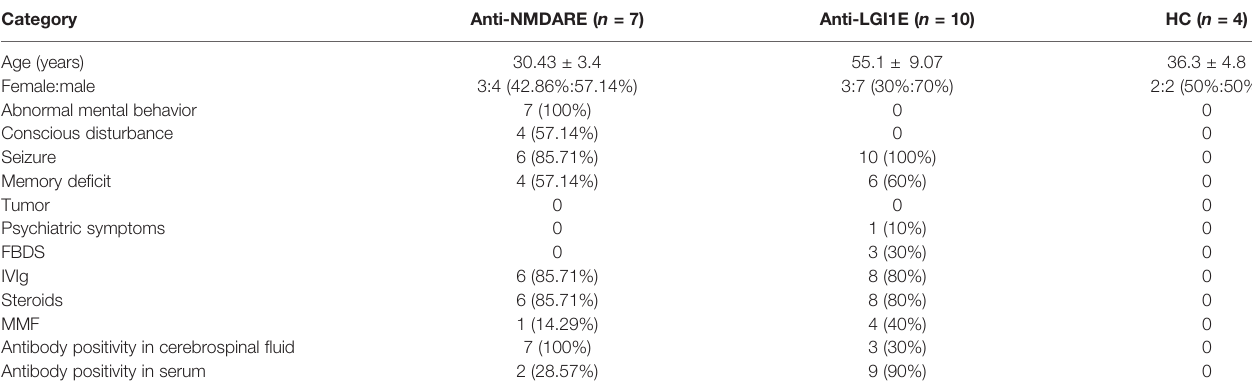
TABLE 1 | Clinical features of studied